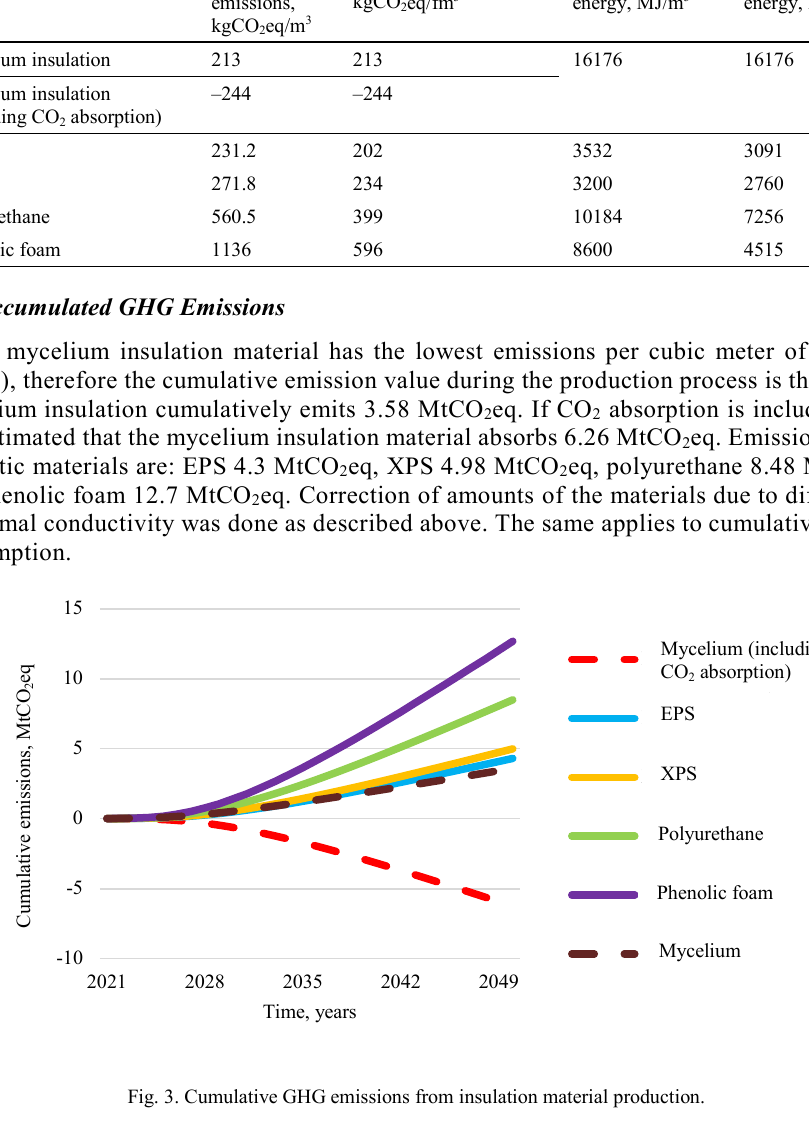
Fig. 3. Cumulative GHG emissions from insulation material